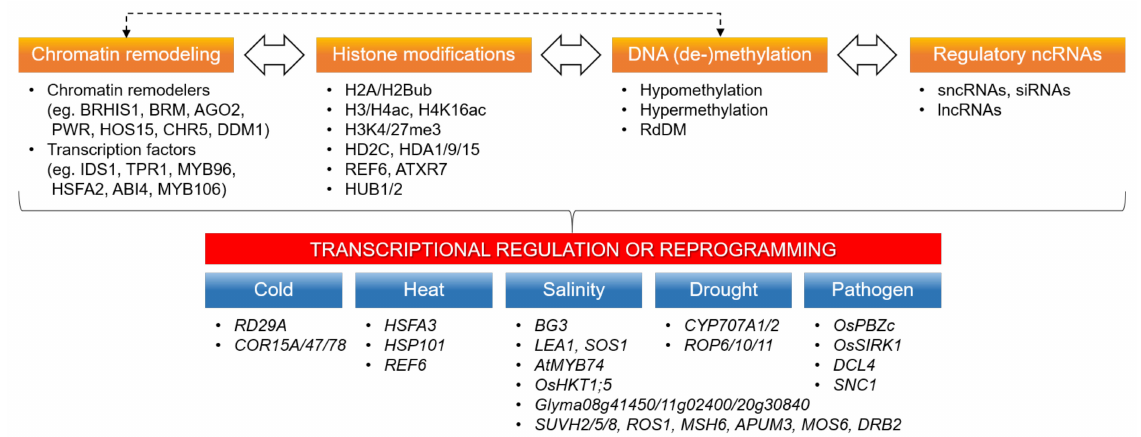
Figure 2. Interplay between histone modifications, chromatin remodeling, DNA (de-)methylation, and ncRNAs in stress- induced transcriptional reprogramming. Cooperative interactions of histone and DNA modifications, histone variants, chromatin remodelers, transcription factors, and ncRNAs in response to cold, heat, salinity, drought, and pathogen infection represent multilayered and multifaceted epigenetic regulation of stress-induced transcriptional